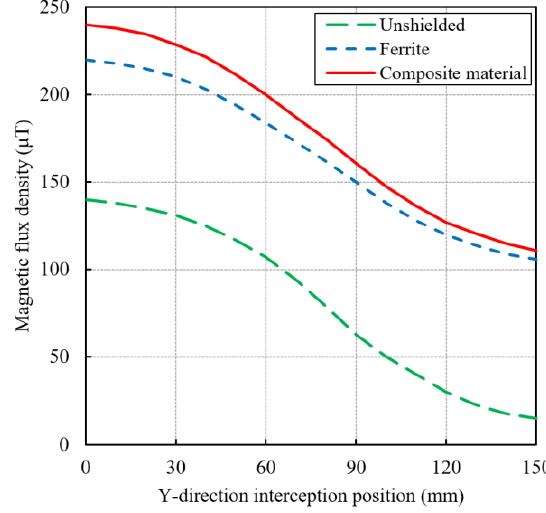
Figure 8. The magnetic flux density distribution on the y-axis direction.